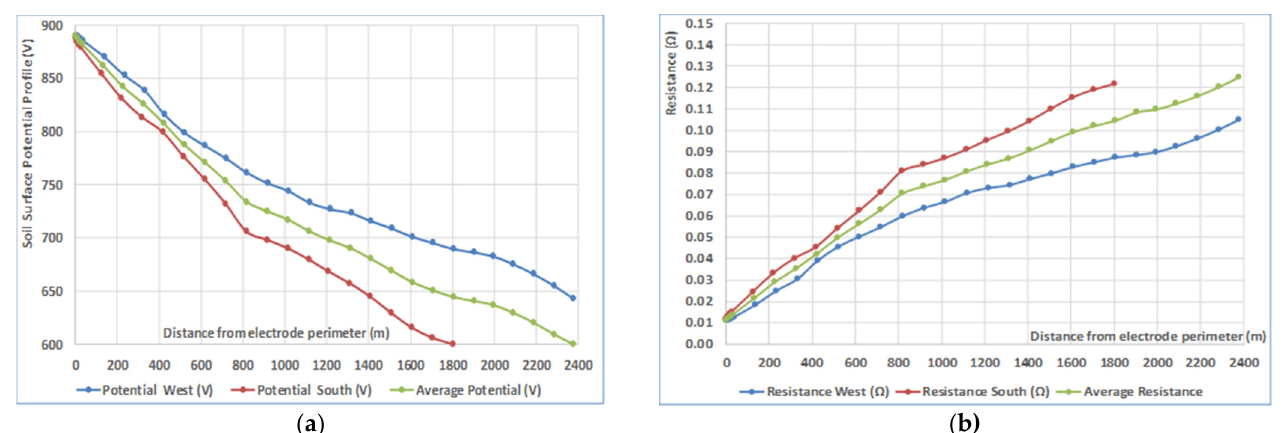
Figure 6. The two soil-surface potential survey directions–West and South (the West line was lim- ited by a river).